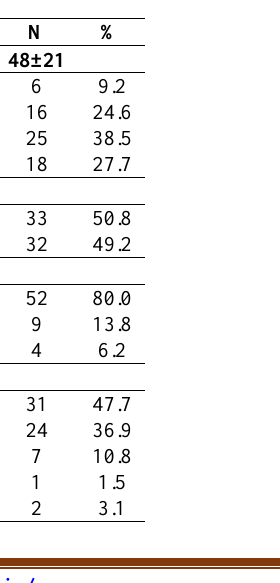
Table 1 : The demographic characteristics of severe malaria patients